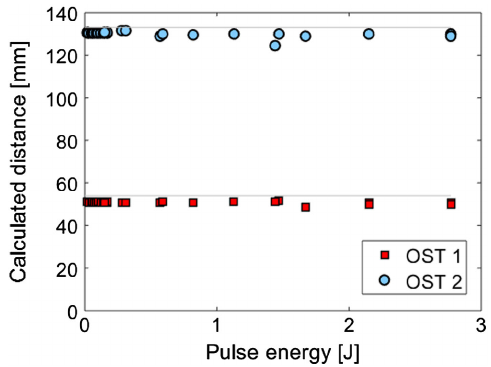
FIG. 12. Distances from heater to OSTs versus heat pulse power, calculated from times of arrival and recommended second sound velocity. For each OST, the average calculated values are shown (dashed lines) as well as the measured distances (solid lines).